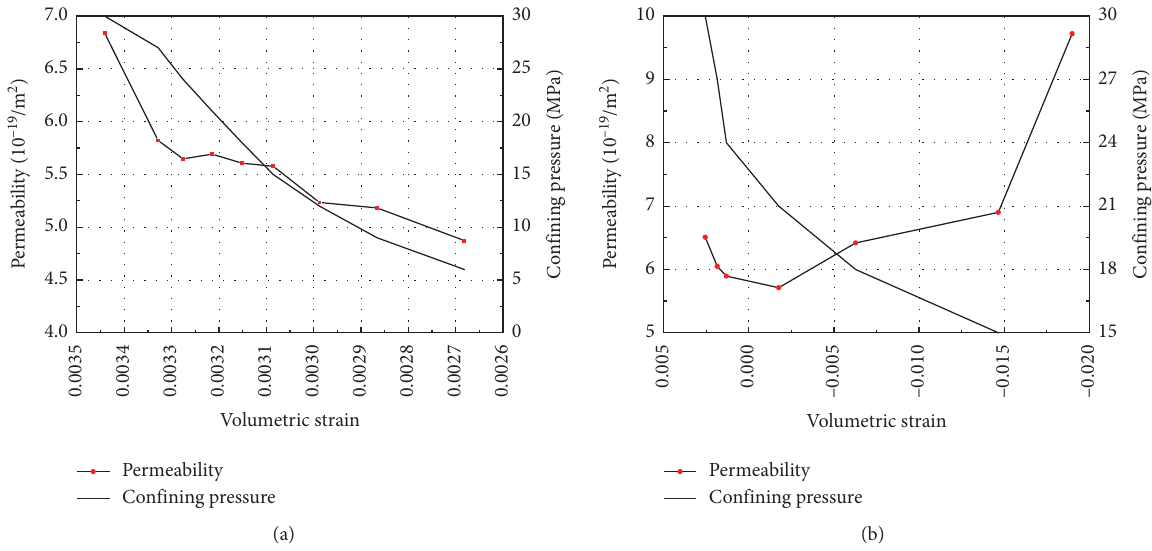
Figure 10: Volume strain versus permeability and pressure of mudstone. (a) Depth � 200 m. (b) Depth �